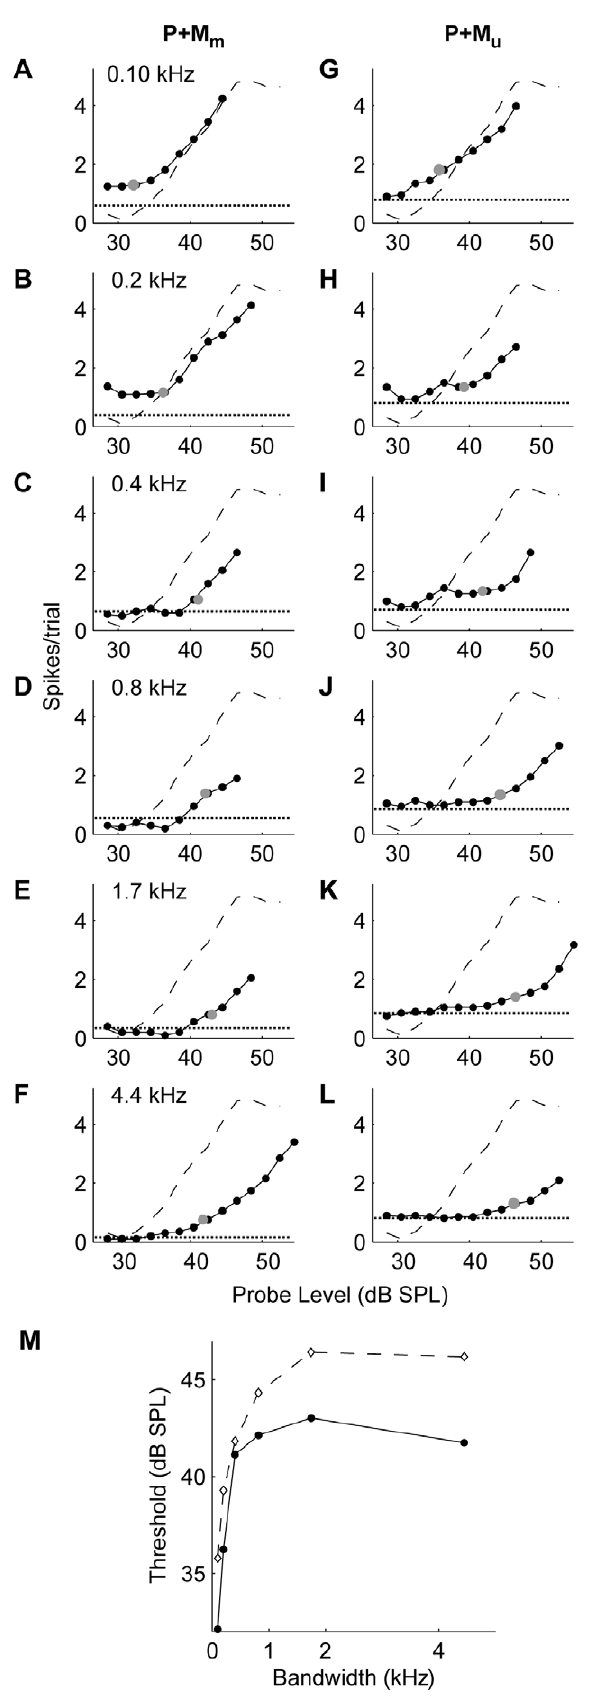
Figure 6. Effect of masker bandwidth on probe detection threshold. A–F: RLFs for M m ; the dashed line indicates the RLF for the probe alone (P) and the solid line shows the mRLF for the probe in the presence of masker, while the dotted line shows the response to masker alone. The masked threshold is indicated by the gray dots. G–L: RLFs in response to M u . M: detection thresholds as a function of the masker bandwidth for P + M u (dashed line) and P + M m (solid